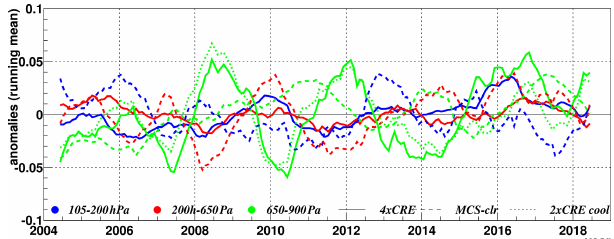
Figure 13. Time series of 12-month running means of deseasonal- ized anomalies of 24h net cloud heating and cooling effects of the CRE (full lines) and MCSs (broken lines), over three vertical lay- ers, and of the CRE in the boundary layer (650–900hPa) over cool regions (dotted green